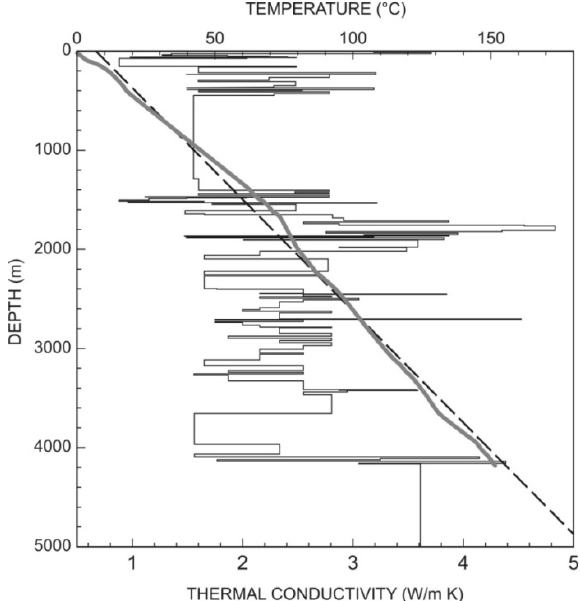
Figure 10. Temperature depth (gray continuous profile) and thermal conductivity k (step line) control based on an example of a location in the deep foreland basin in British Columbia part (123°W 57°N; see Figure 3 for location). Approximation of the mean thermal gradient is also shown by a broken